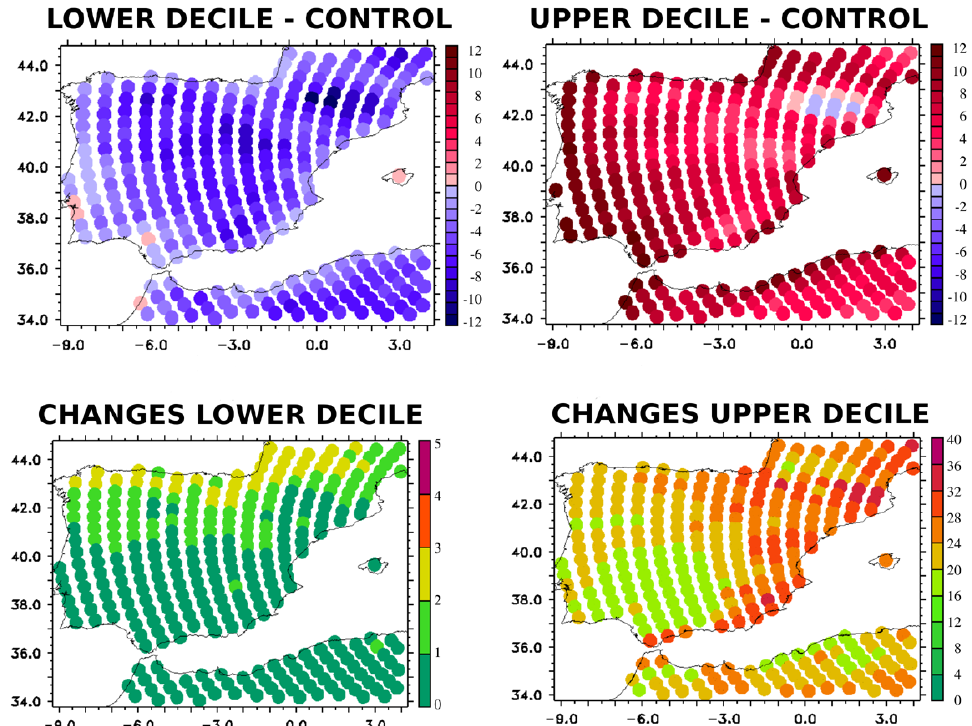
Fig. 8. In the top row, the lower decile values of the minimum temperature (left) and the upper decile values of the historical simulations (right). In the botton row, the percentages of exceedance of the historical lower decile values (left) and upper decile values (right) in the temperatures of the scenario